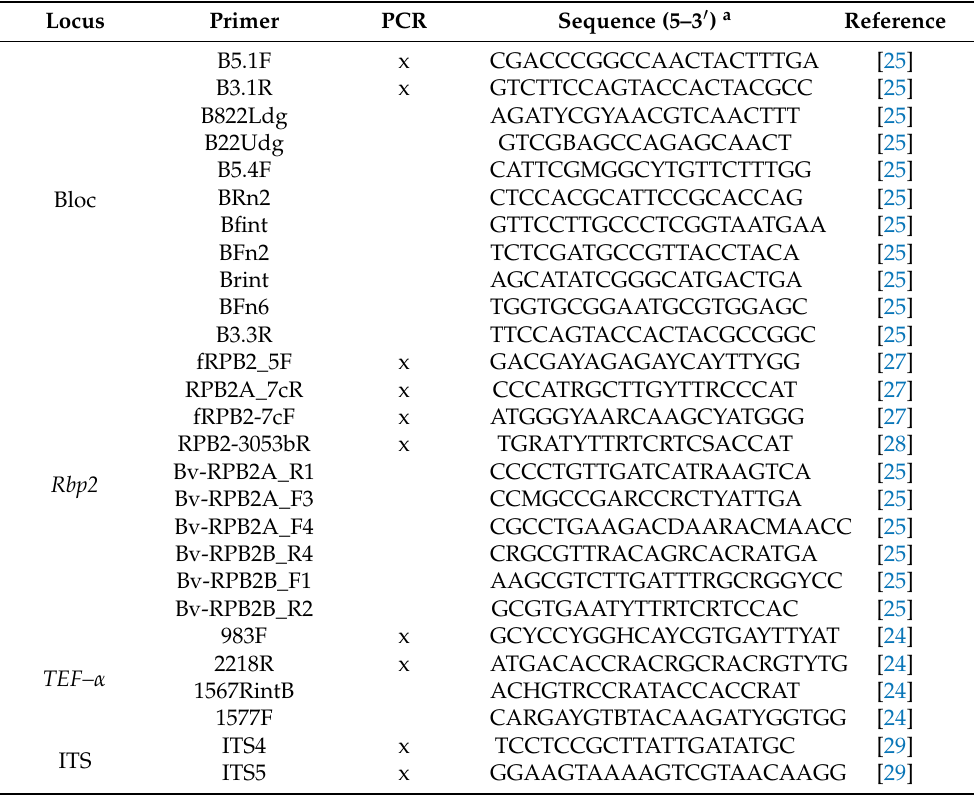
Table 1. Primers for PCR amplification and